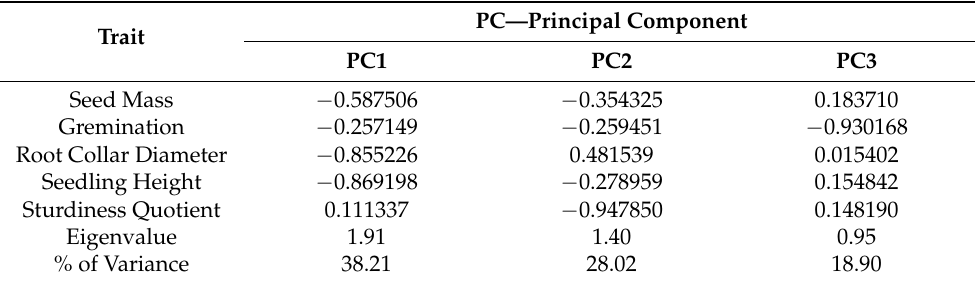
Table 2. Pearson’s correlation coefficients between five seeds and seedling traits and scores of the first three principal